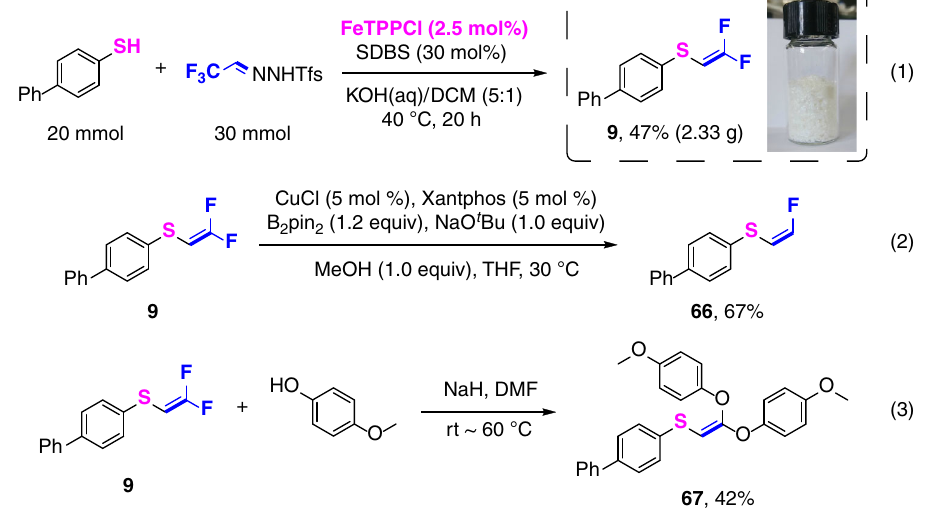
Fig. 4 Gram-scale synthesis and further transformations. Gram-scale synthesis of product 9 (1). Mono-de fl uorination of product 9 (2). Double de fl uorination of product 9